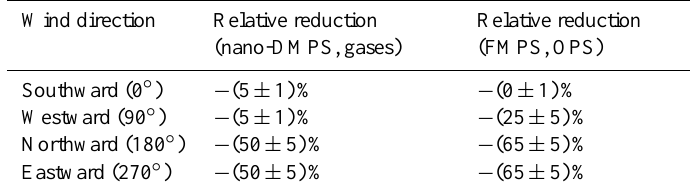
Table 2. Relative dilution at standard wind speed for four different wind directions between the hill top and the closed forest edge opposite to wind